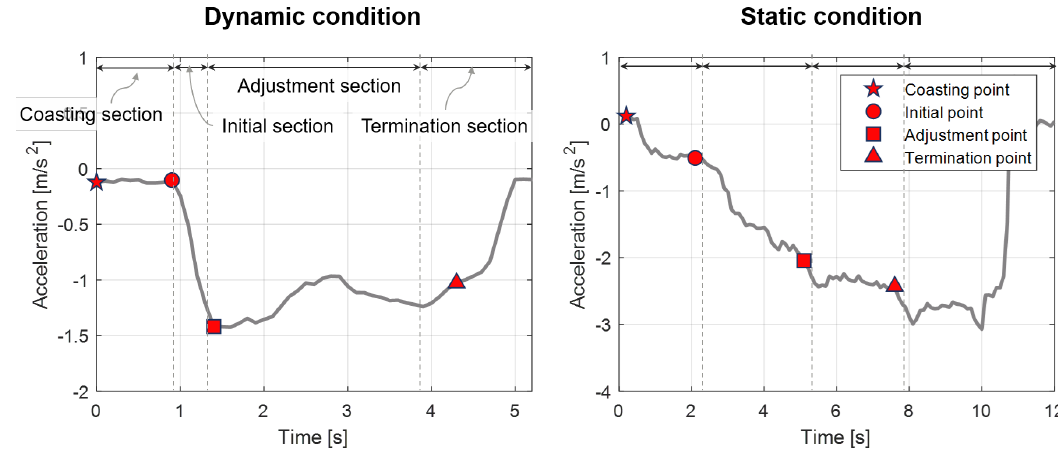
Figure 7. Description of the braking section about various deceleration conditions.